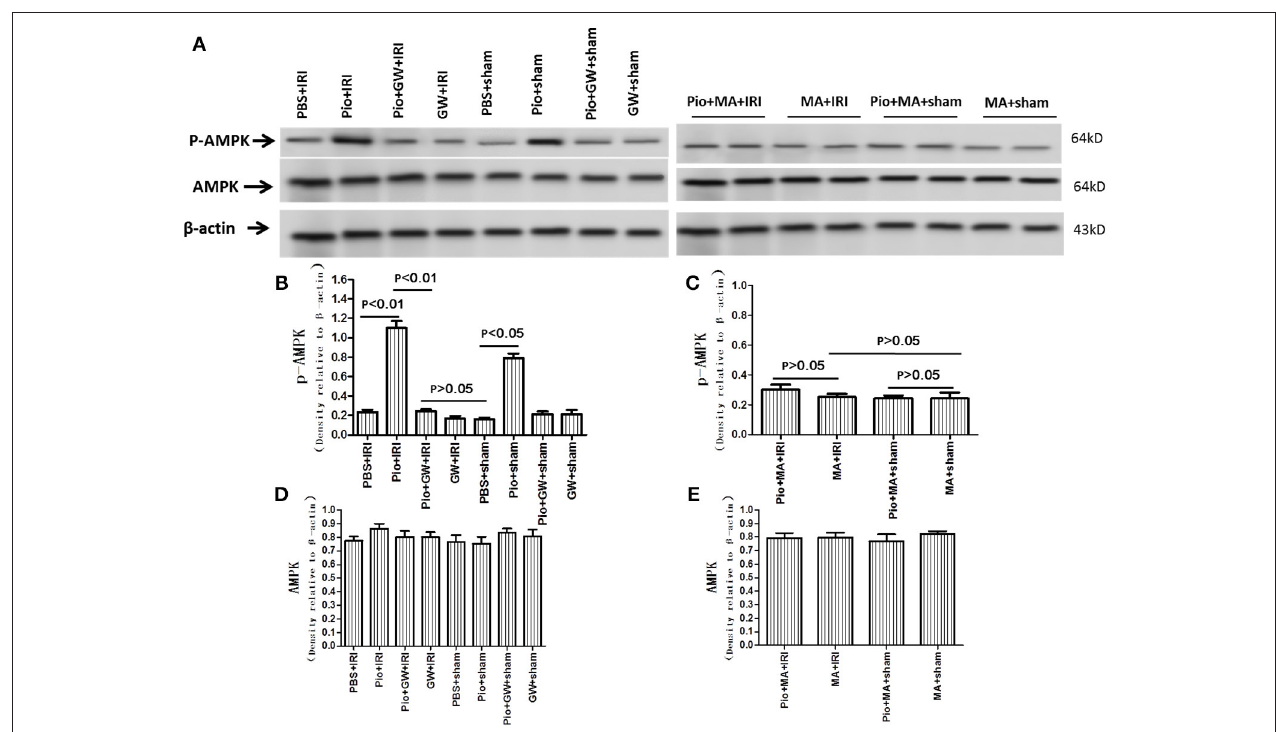
FIGURE 10 | Expression of AMPK protein in renal tissue at 24h after renal IRI. (A) Representative western blots show phosphorylated AMPK and total AMPK protein levels in the kidneys. (B–E) Quantitative analysis of phosphorylated AMPK protein and total AMPK protein levels in the kidneys. Values are expressed as means ± SE (B–E) . n = 6 in each group. AMPK, AMP-activated protein kinase. p-AMPK, phosphorylated